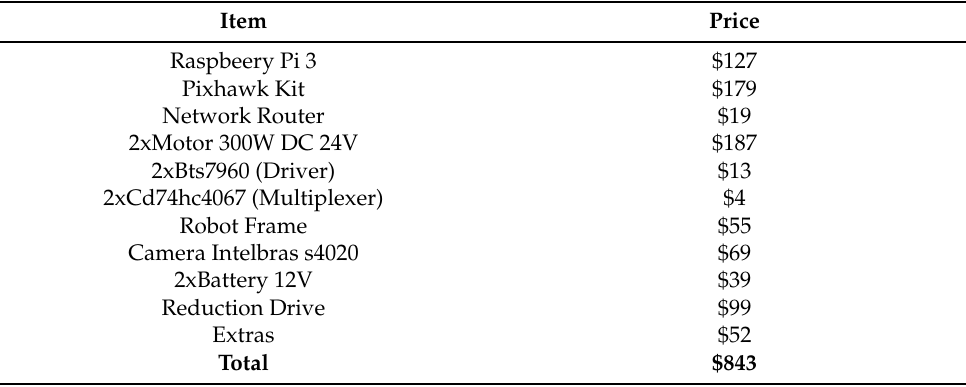
Table 3. Main components of the robot and their respective costs.